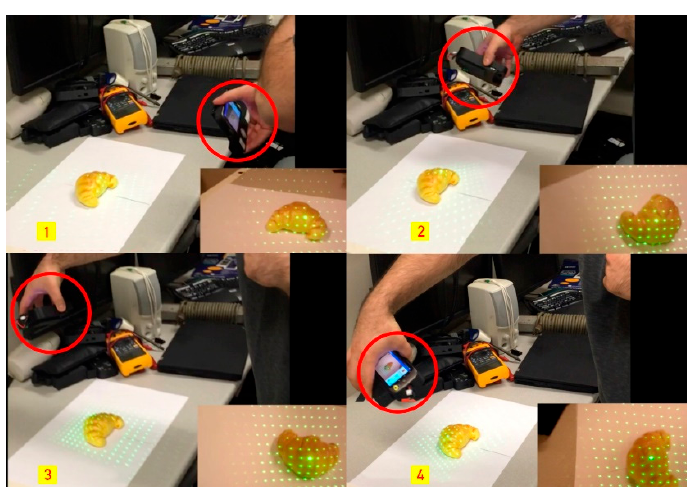
Figure 7. 360-degree scanning of a croissant using the DDRS, which allows 360-degree scanning to get the visual information of the food from the side angles. The figure shows snapshots of the scanning process using the DDRS (circled in red) in counter-clockwise.